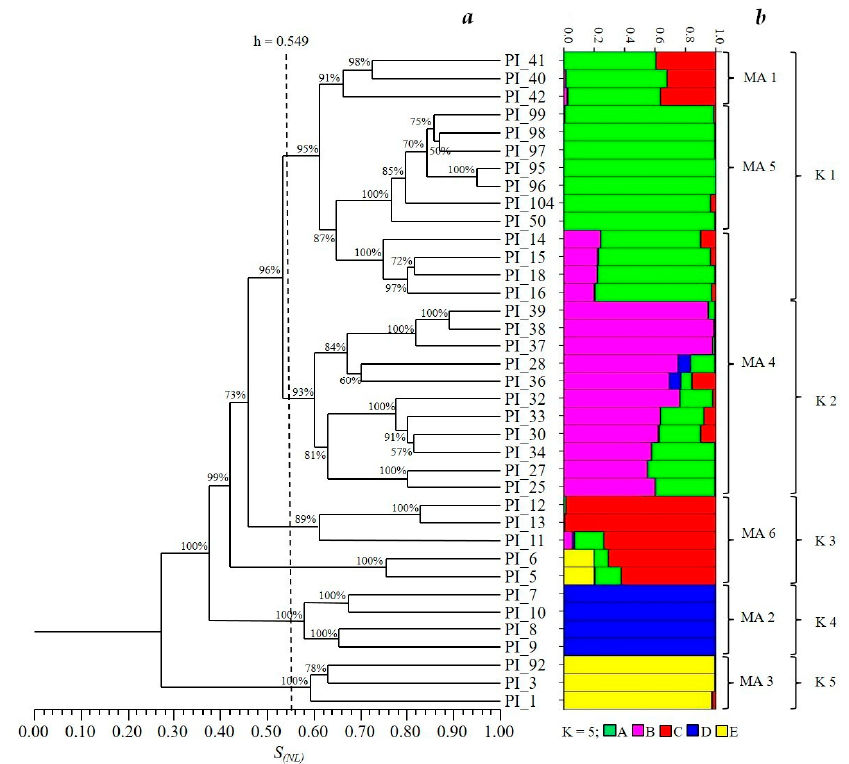
Figure 1. The dendrogram ( a ) based on the similarity coefficient ( S NL ) and UPGMA using Agglom- erative Hierarchical Clustering of 37 accessions of F. nilgerrensis based on AFLP markers. A thresh- old (h) was used to separate six clusters. Bootstrap values over 50% based on 1000 resamplings of the data set are indicated on the branches of dendrogram. The mountain areas (MAs) and plant codes are listed in Table 1. ( b ) Bayesian cluster analysis of the 37 samples of F. nilgerrensis . Sub- populations ( K ) are indicated at the right side of the bar plot. The strips of different colors repre- sent membership coefficients for K = 5, calculated by STRUCTURE software.